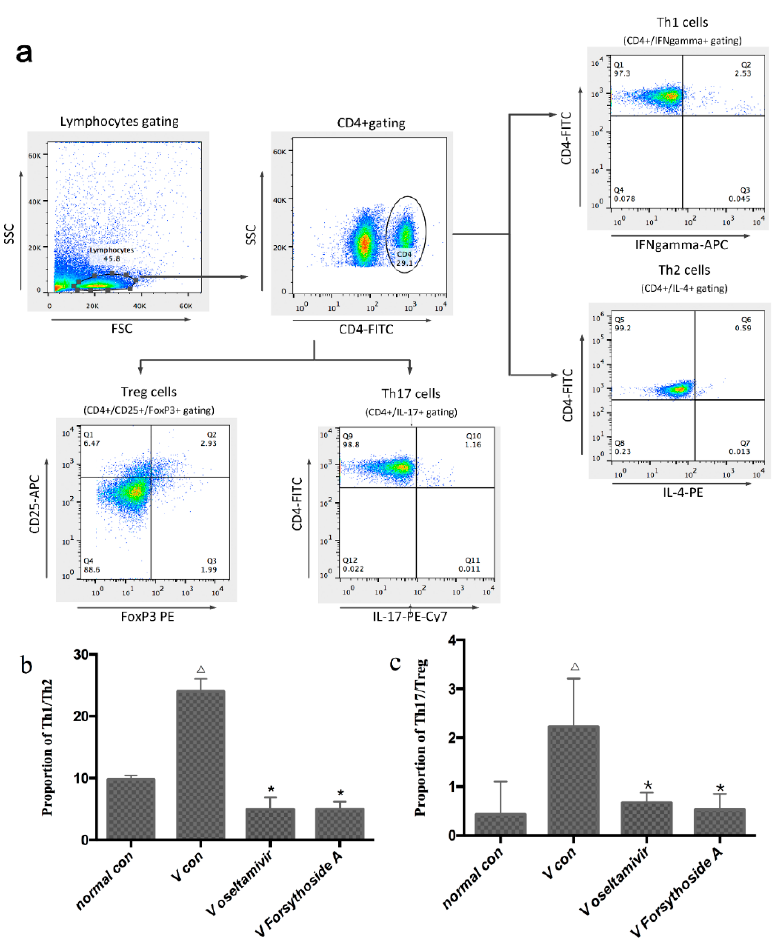
Figure 7. Flow cytometry was used to detect the proportion of the T cell subsets Th1/Th2 and Th17/Treg. ( a ) Flow cytometry analysis of CD4 + T cell subsets; ( b , c ) Changes in the proportion of Th1/Th2 cells and Th17/Treg cells. Δ p < 0.01 compared with normal con . * p < 0.01 compared with V con .